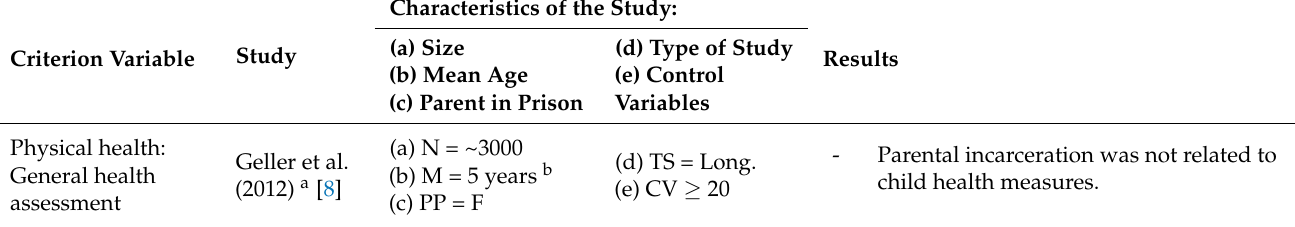
Table A1. Summary of studies included in the systematic review. Children aged 0 to 6 years